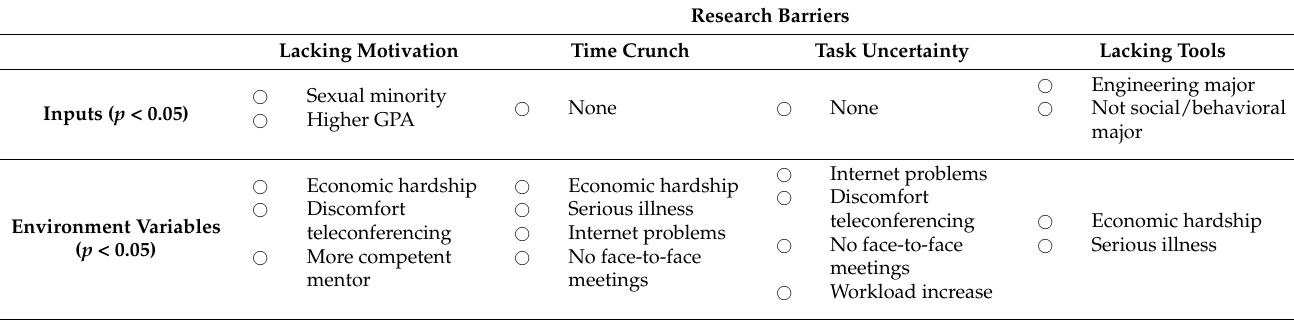
Table 5 reviews the significant predictors ( p < 0.05) for each barrier to research progress. Table 5. Summary of significant findings for input and environment variables (from Tables 4 and